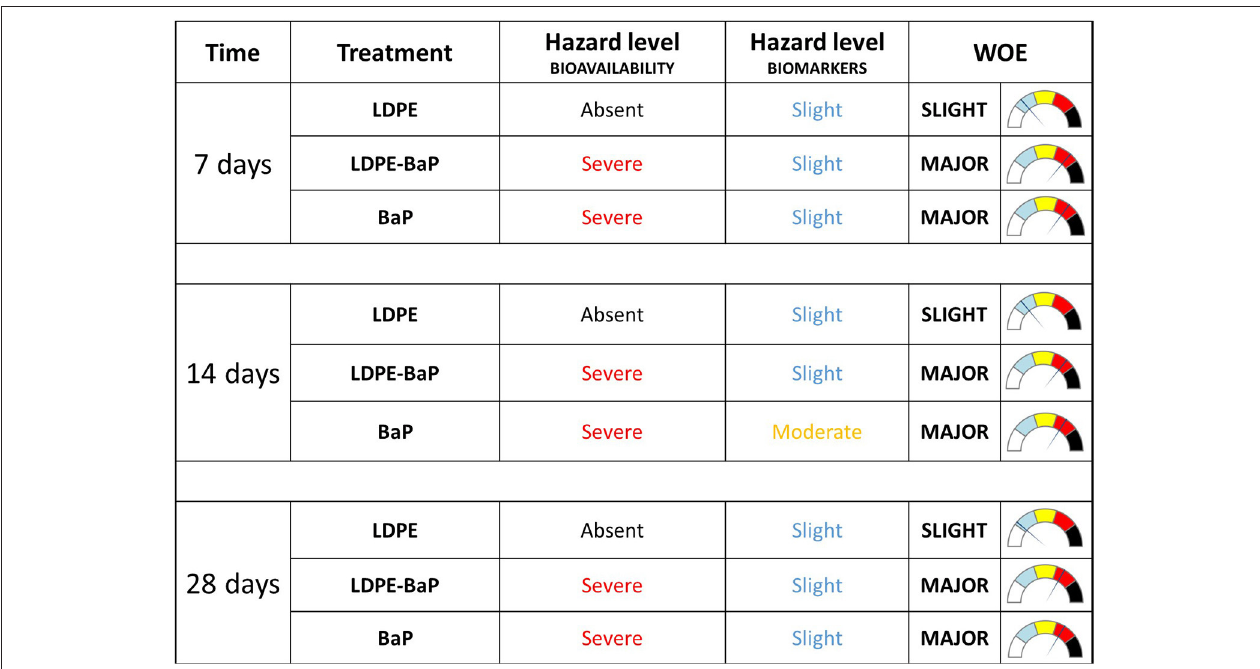
FIGURE 8 | Weighted elaboration of bioaccumulation and biomarkers data in mussels exposed for 7, 14, 28 days to LDPE, BaP, and LDPE-BaP. The assigned classes of hazard are given. Treatments: LDPE, virgin low density polyethylene; BaP, Benzo(a)pyrene alone; LDPE-BaP, Benzo(a)pyrene-contaminated polyethylene.